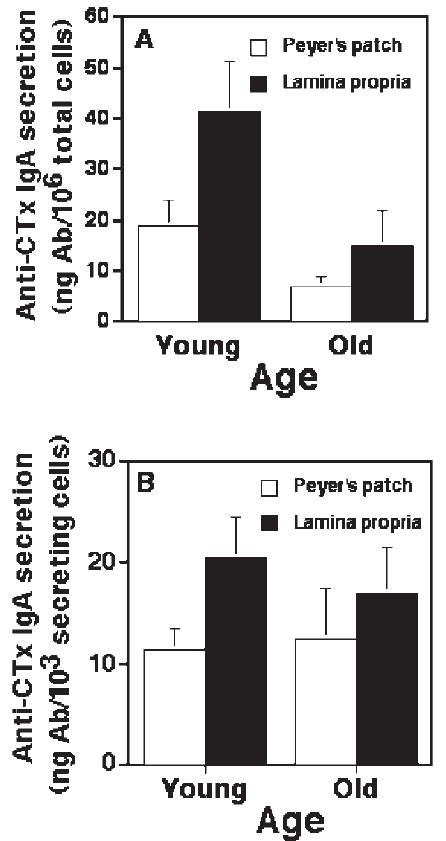
FIGURE 4 Anti-CTx IgA levels in cultures of lymphocytes isolated from PPs and small intestinal LP of young and old rats 7 days after intraduodenal boost with cholera holotoxin. The data are expressed as (A) nanograms of anti-CTx IgA antibody per 10 6 total lymphocytes and (B) nanograms of anti-CTx IgA antibody per 10 3 anti-CTx antibody- secreting cells. The lower antibody levels ( P , 0.05) measured in (A) reflect fewer antibody-secreting cells per 10 6 total lymphocytes in old rats since the antibody-secreting capacity of the specific plasma cells is undiminished with age (B). The values represent the mean ^ SEM for 5 animals per age